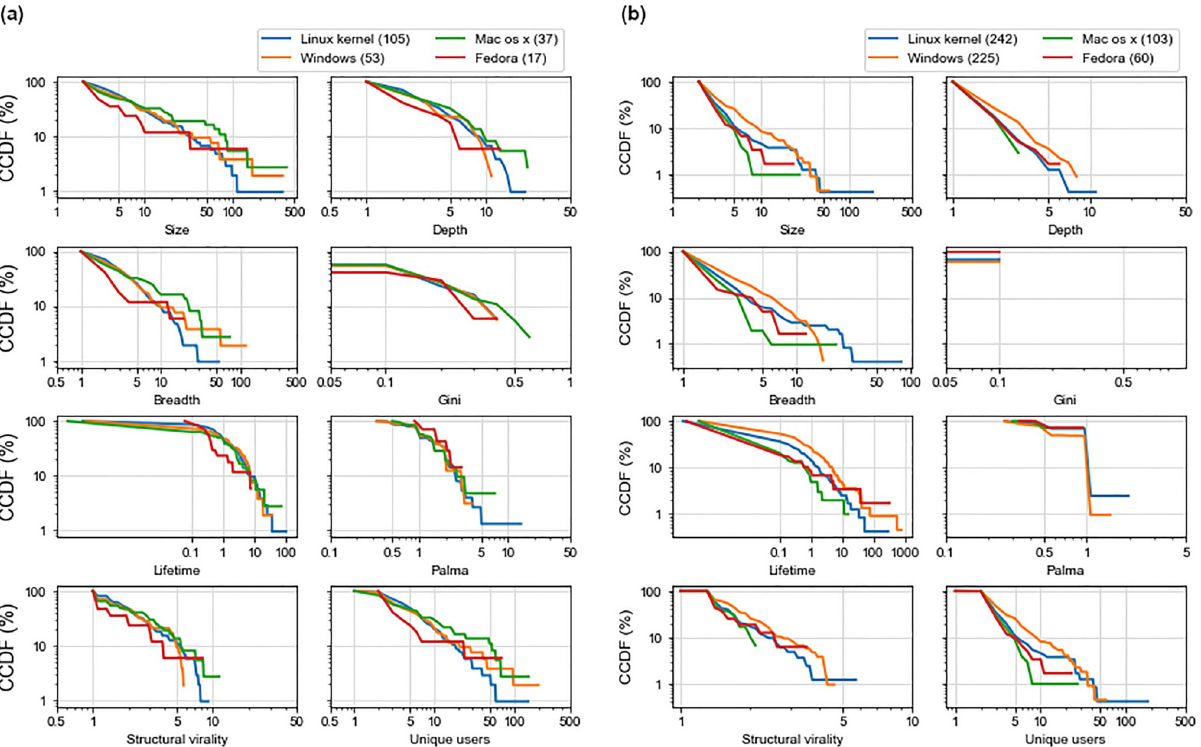
Fig 11. CCDF plots of information spread measurements on Reddit and Twitter for different Operating Systems (OS). (a) Reddit (b) Twitter.